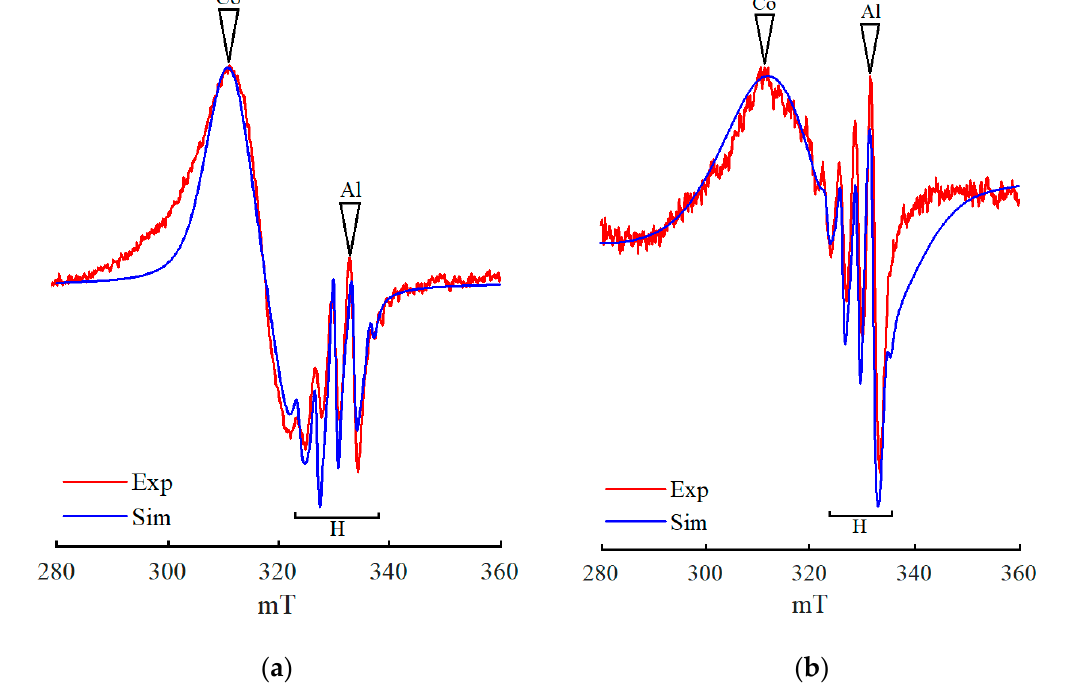
Figure 9. Real (red line) and simulated (blue line) EPR spectrum of the Co(acac) 2 –AlEt 3 catalytic system formed in hexane in the presence of: ( a ) toluene, ( b ) durene, recorded at 293 K. Spectrum ( a ) was taken from [69,77].